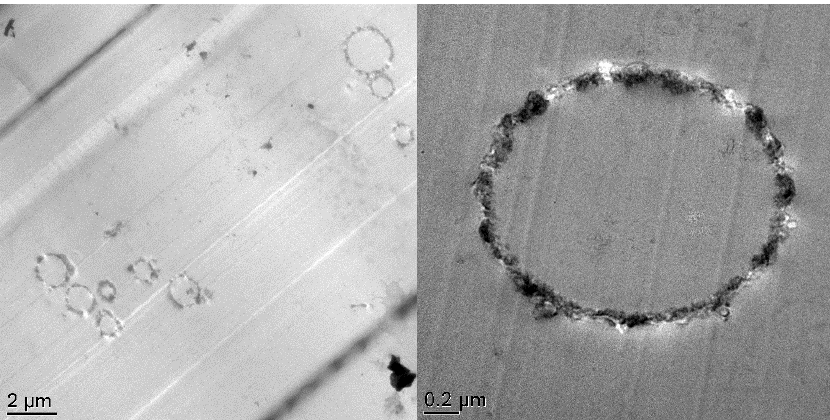
Figure 7. TEM micrographs of SiO 2 @IL microcapsules embedded in an epoxy-amine network at different magnifications.